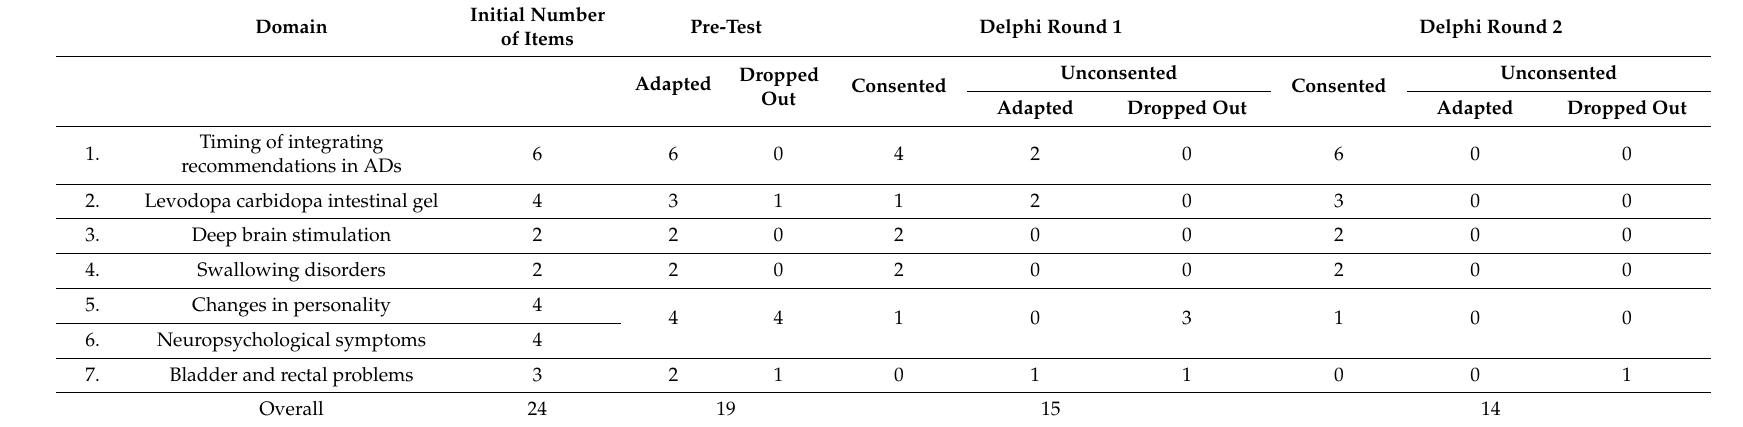
Table 2. Central domains and number of Delphi